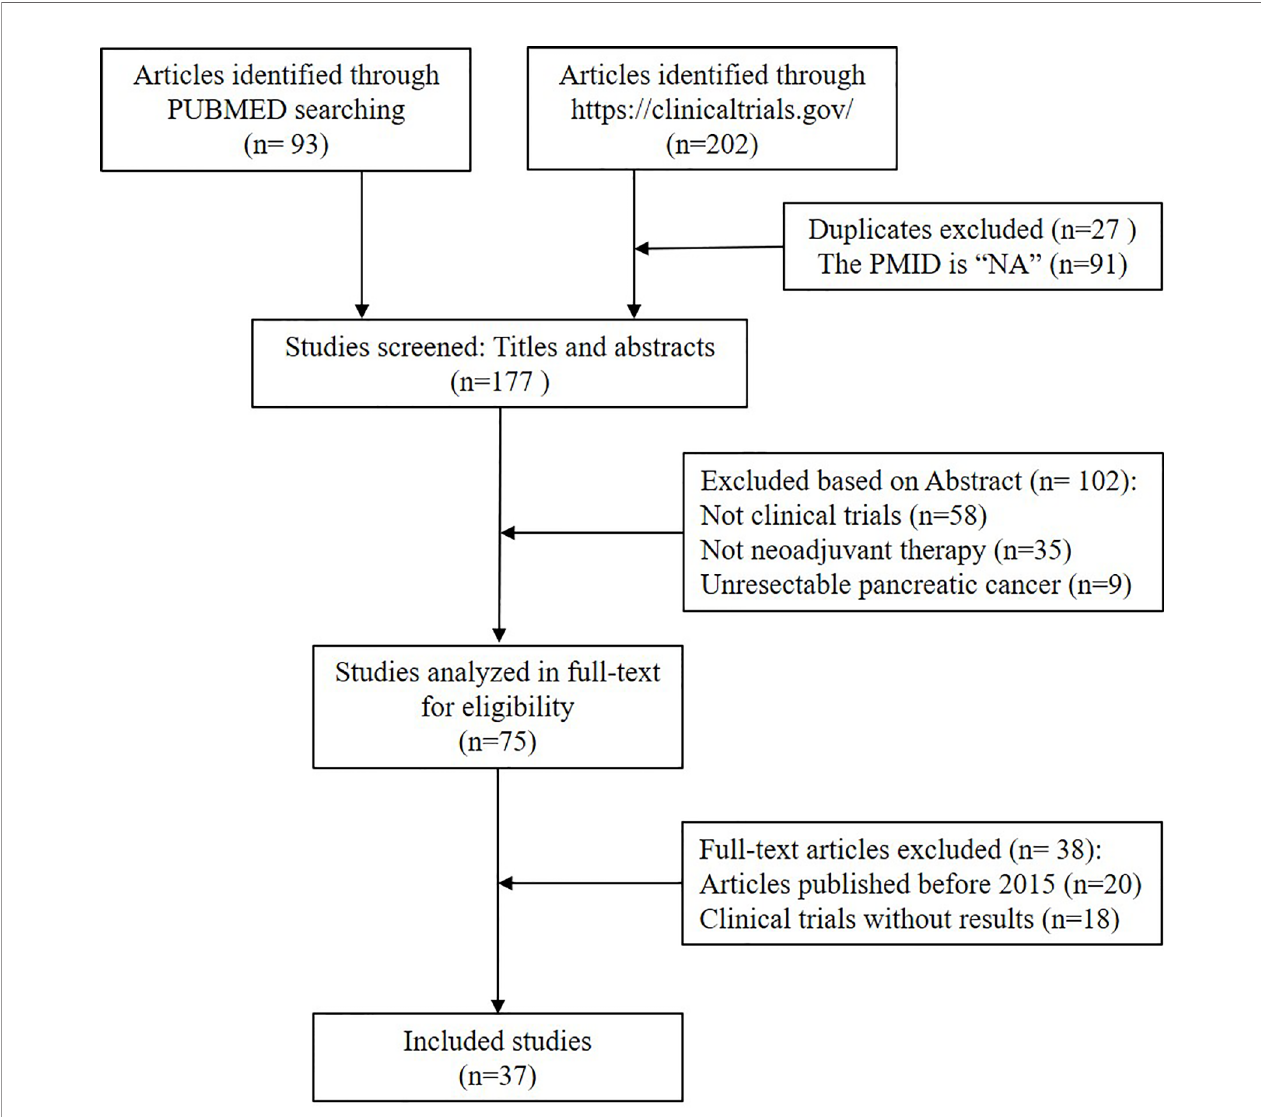
FIGURE 1 | Flowchart of the included studies. Publications were retrieved by searching the following databases: PubMed (n = 93) and (https://clinicaltrials.gov/) (n = 202), with a total of 295 publications. The search strategy included keywords related to pancreatic cancer and neoadjuvant. All citations were screened to identify relevant studies, fi rstly, duplicate and unavailable PMID studies were excluded (27 duplicate and 91 unavailable PMID). Secondly, by the title and abstract (n = 102) and, thirdly, by full text screening (n = 38). A total of 258 publications were excluded. Finally, 37 were eligible for assessment by full